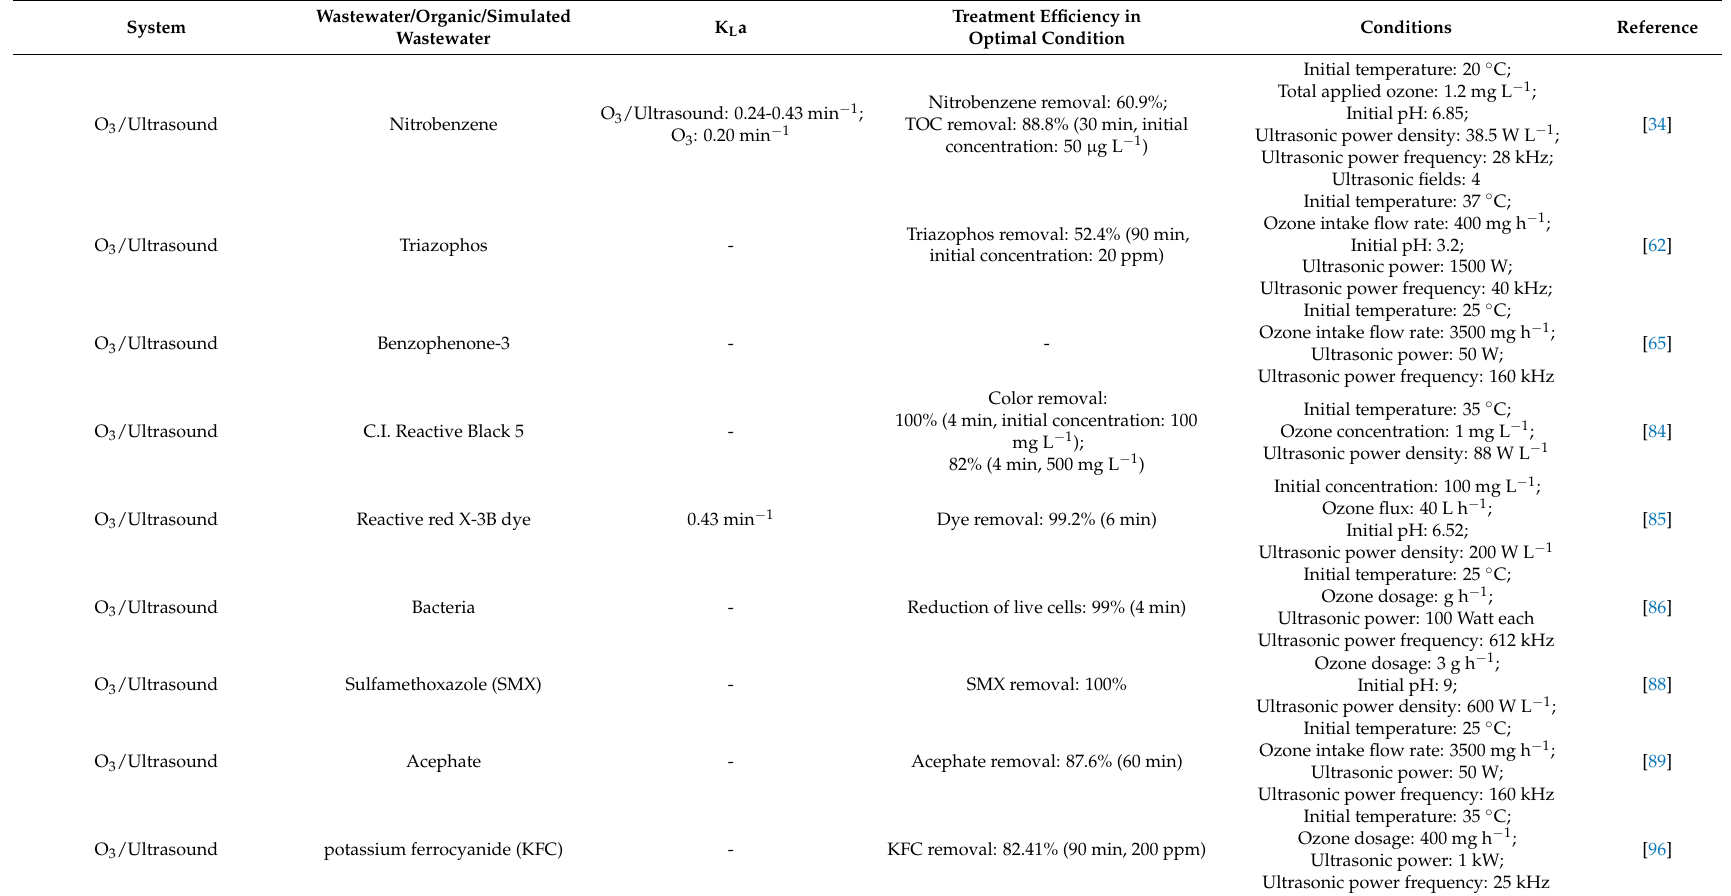
Table 2. Overview on wastewater treatment through ultrasonic catalytic ozonation